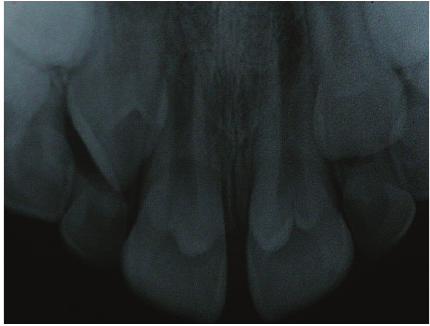
Figure 4: Radiographic appearance of the talon cusp.